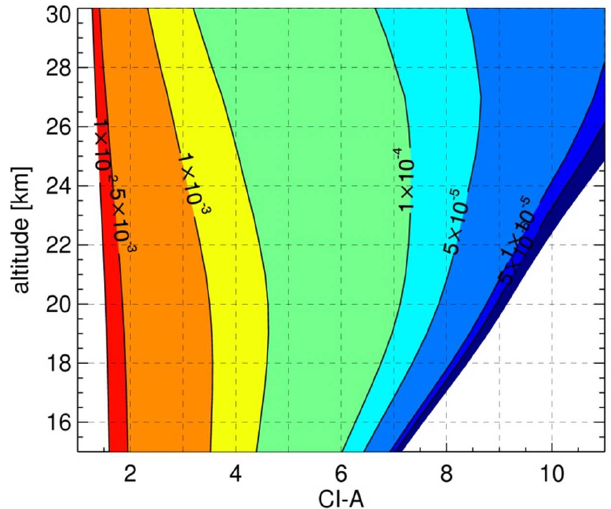
Fig. 4. Variation of equivalent 12µm extinction, for 65 ◦ N to 20 ◦ N in January, as a function of altitude and CI-A. Different colours correspond to the extinction limits between 1 × 10 − 2 km − 1 and 1 × 10 − 6 km − 1